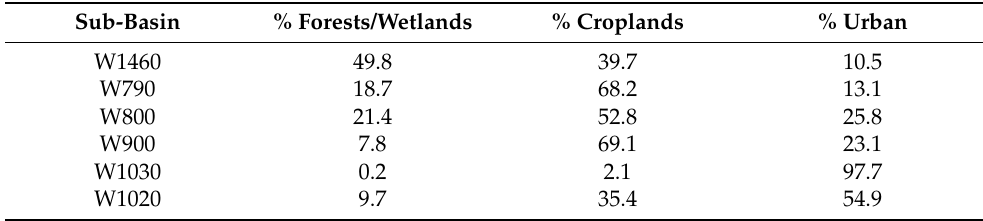
Table 8. Vegetation classes of the six studied sub-basins.